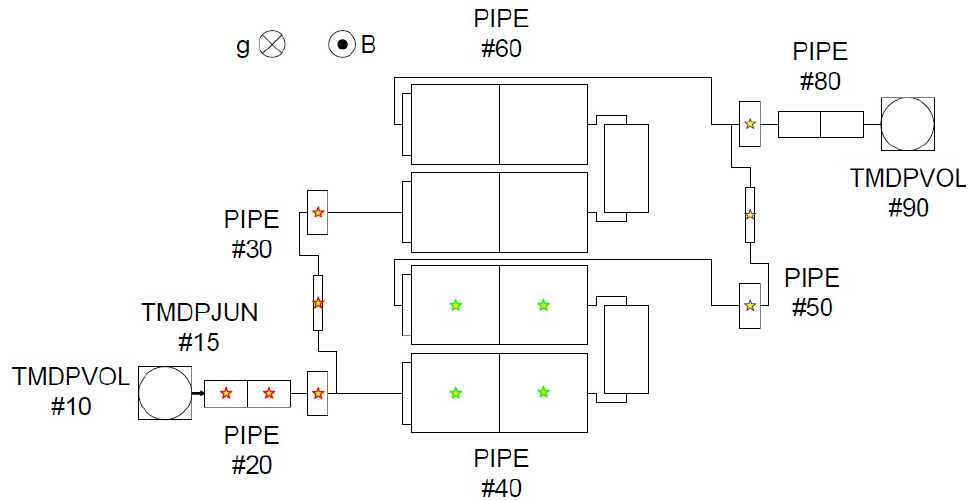
Figure 15. Meshing scheme of the